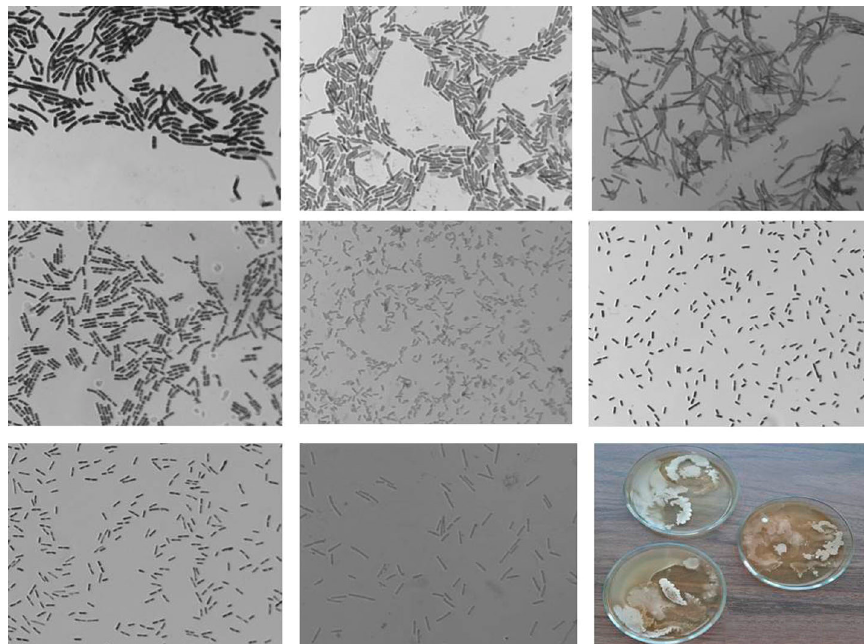
Figure 3. Photo of bacteria sown from potato tubers treated with Se/AG NC (1000× zoom).